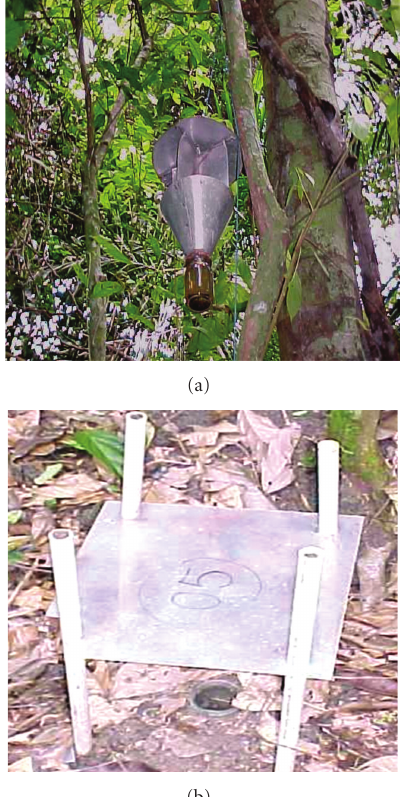
Figure 1: Traps used to capture insects. (a) Escolit´ıdeo/Curitiba trap-EC and (b) Pitfall